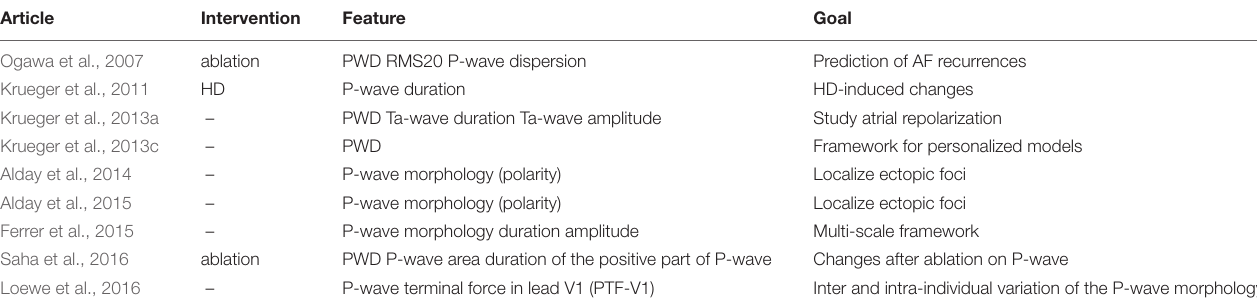
TABLE 3 | Features used toward the analysis of the P-wave, during SR, using computational modeling